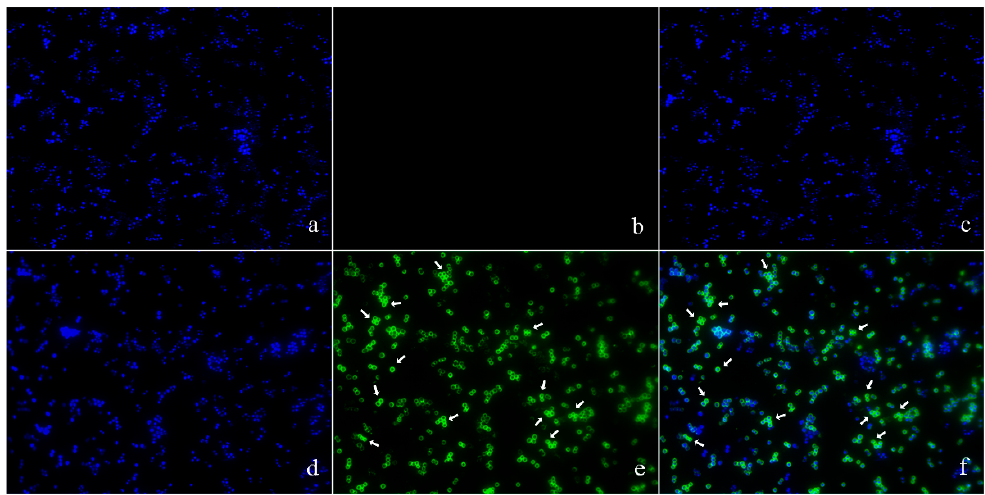
Figure 3. The locations of pBD2 on bacteria were detected by IFM (×1000). ( a ), ( b ), ( c ) Control bacteria (without the first antibody) dyed by DAPI (4 ′ ,6-diamidino-2-phenylindole), FITC, and DAPI/FITC, respectively; ( d ), ( e ), ( f ) bacteria dyed by DAPI, FITC, and DAPI/FITC, respectively. Bacteria were magnified 1000 times. The green fluorescence, which is the result of staining with FITC-labeled secondary antibodies, indicates the location of pBD2. The blue fluorescence, which is the result of staining with DAPI, indicates the location of bacterial DNA. The arrows indicate the cells in which pDB2 is likely to be located inside.